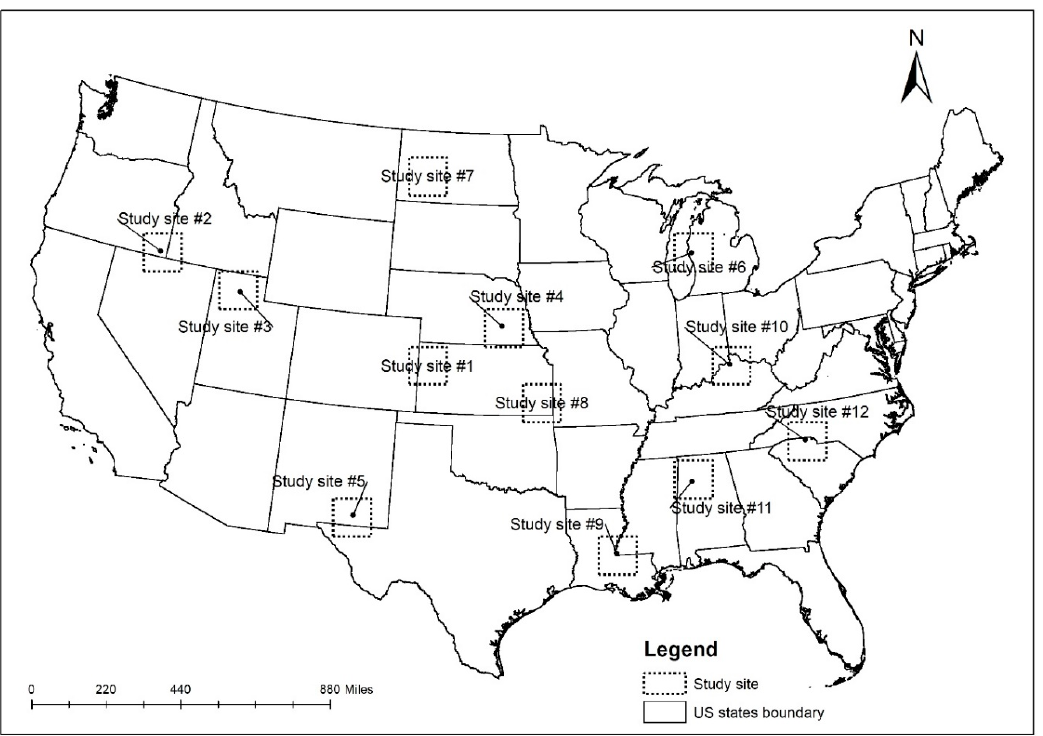
Figure 1. Locations of the twelve study sites. Table 3. Two levels of the classification scheme (The Level II is from the NLCD 2016 product legend and the class names ending with the (#) symbol are not contained within any of the twelve study sites).